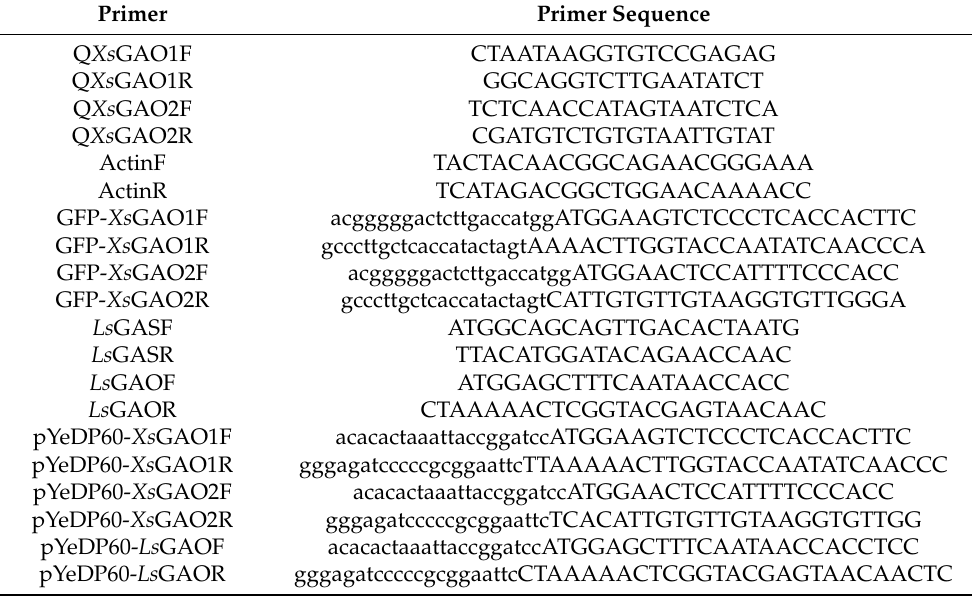
Table A2. Primers used in RT-PCR, qRT-PCR, and expression in